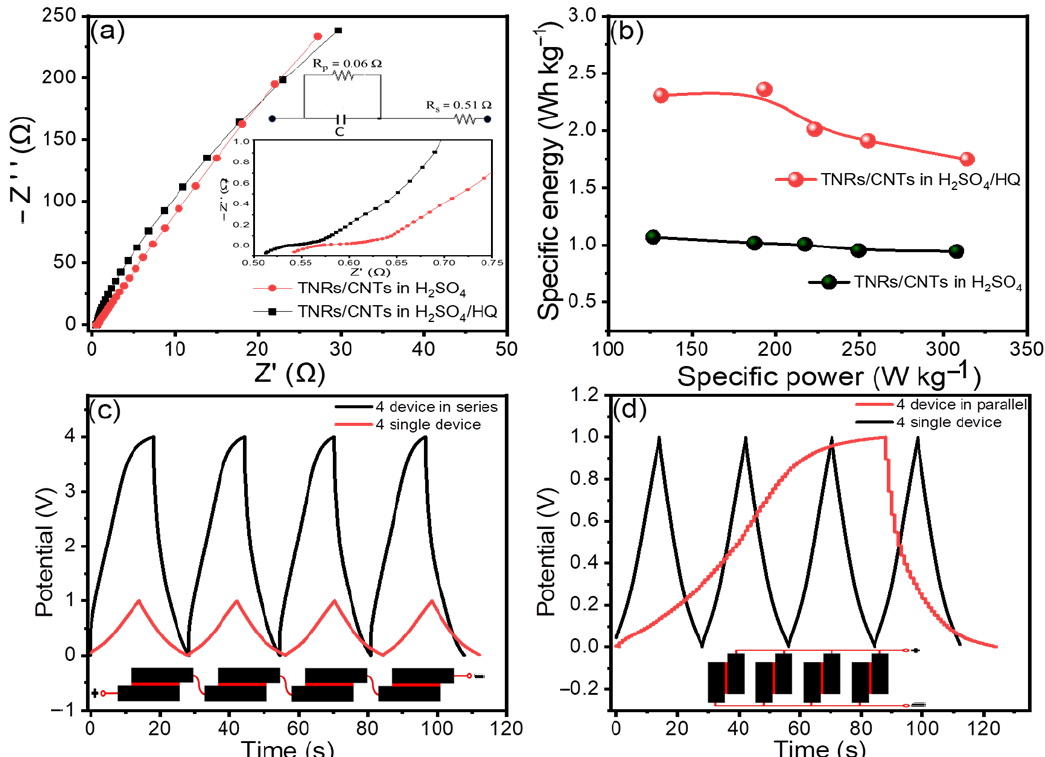
Figure 5. ( a ) TNR/CNT Nyquist plots in H 2 SO 4 and H 2 SO 4 /HQ, respectively. The inset shows enhanced Nyquist plots in the high-frequency area; ( b ) a Ragone plot of specific power vs. specific energy for TNR/CNTs in H 2 SO 4 and H 2 SO 4 /HQ, respectively; and CD curves of TNR/CNTs in H 2 SO 4 /HQ for a single cell and tandem cells at 1.9 A g − 1 ( c ) in series, and ( d ) in